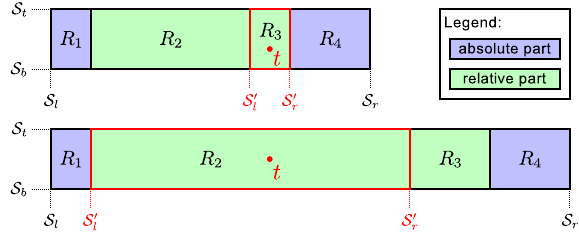
Figure 4: The Split operator subdivides the current scope along a certain axis. An absolute size policy will always produce an element of a fixed size (blue) whereas a relative size policy will calculate the actual size depending on the defined ratios between all relative elements (green). The element that will be further evaluated by the grammar is determined by successively checking which interval of the split is hit by the texture coordinates t